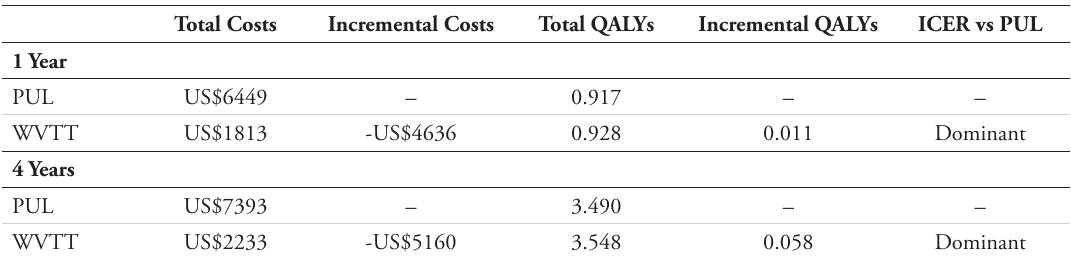
Table 3. Costs, QALYs, and ICERs at 1 and 4 Years for PUL and